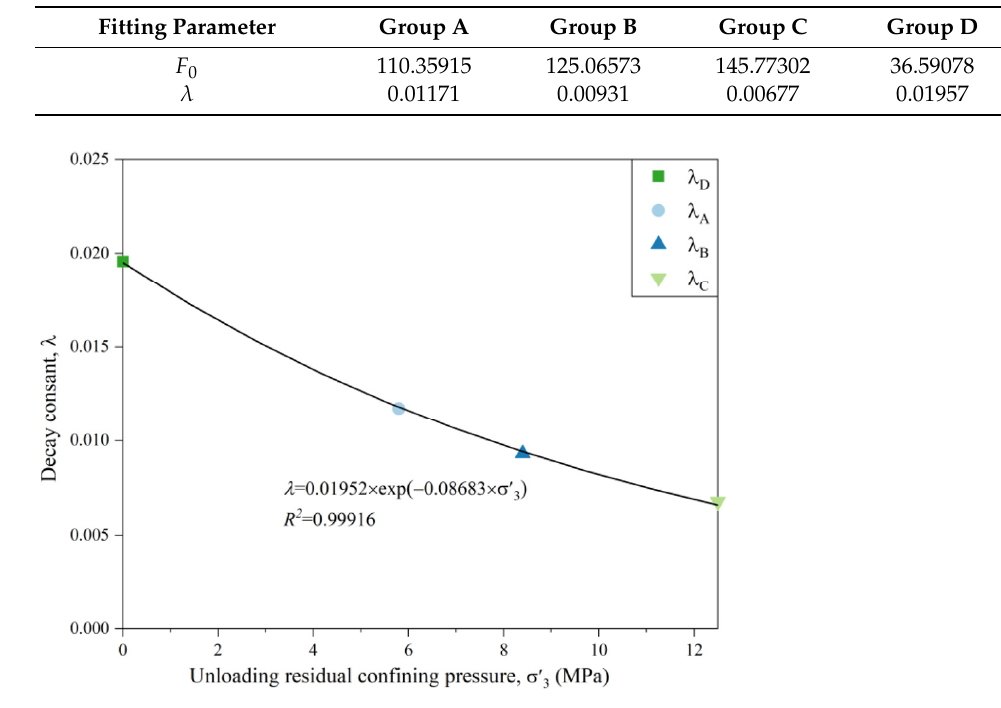
Table 3. Fitting parameter values of freeze-thaw number and peak strength of the unloaded-damaged samples.